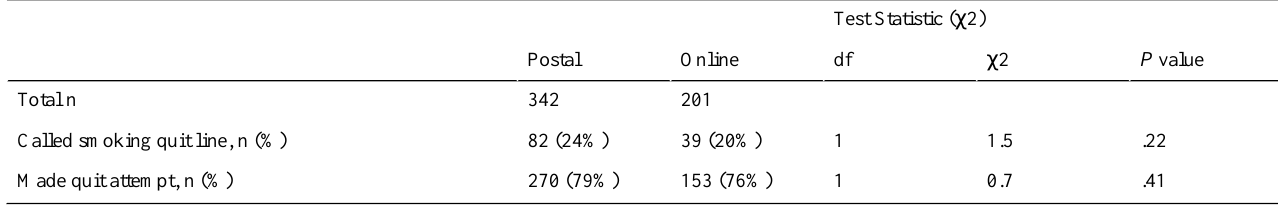
Table 2. Comparison of postal and online baseline respondents at 2-month telephone survey